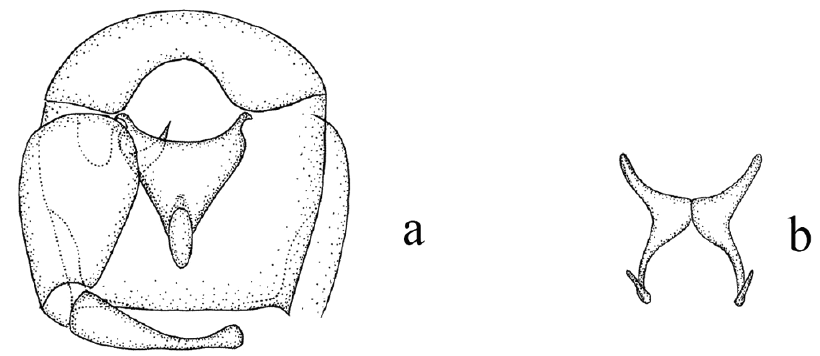
Figure 3. Culicoides ( A. ) fenggangensis sp. n. a Genitalia and aedeagus (parameres absent), ventral view b parameres, ventral Table 2. TR and F-T of all legs of C. fenggangensis sp. n. ( ♂ ).